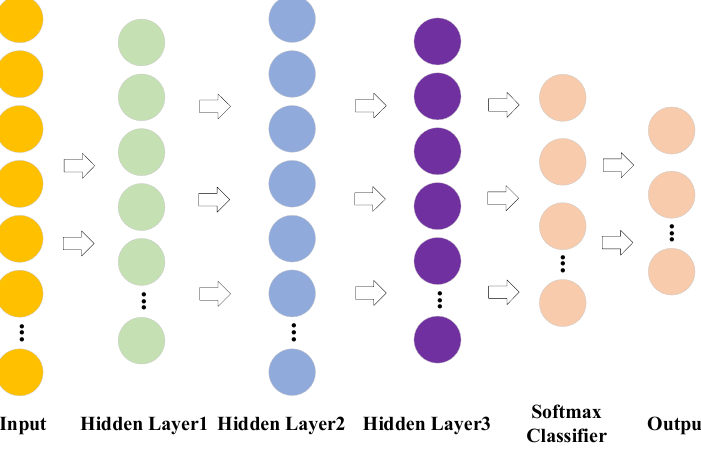
Figure 2. Structure of the proposed DAEN. DAEN uses the Sigmoid activation function for nonlinear mapping [30]. The Sigmoid activation function is defined as